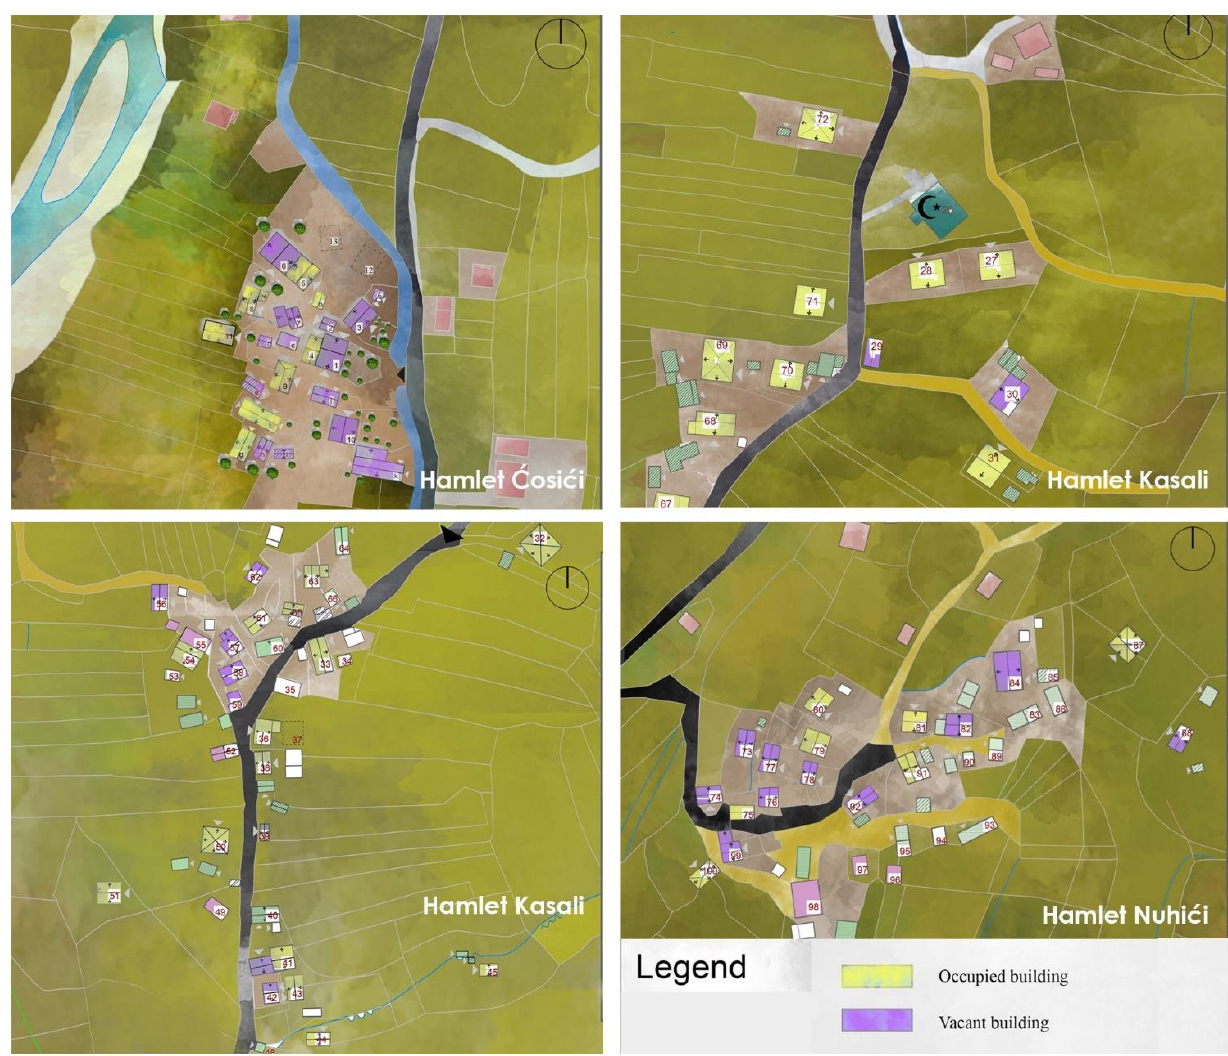
Figure 6. Village Idbar occupancy map for the hamlets Ċosići, Kasali, and Nuhići. (Source: